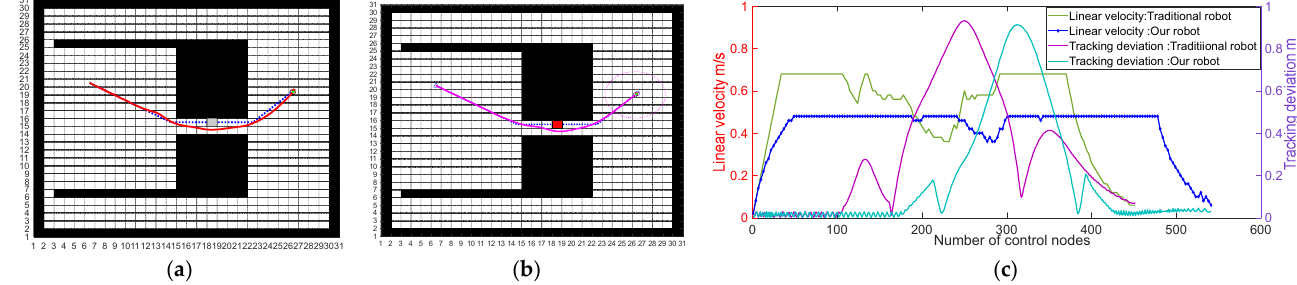
Figure 19. Map 6’s experimental results. ( a ) Traditional robot. ( b ) Our robot. ( c ) Two-coordinate plot of linear velocity and tracking deviation.